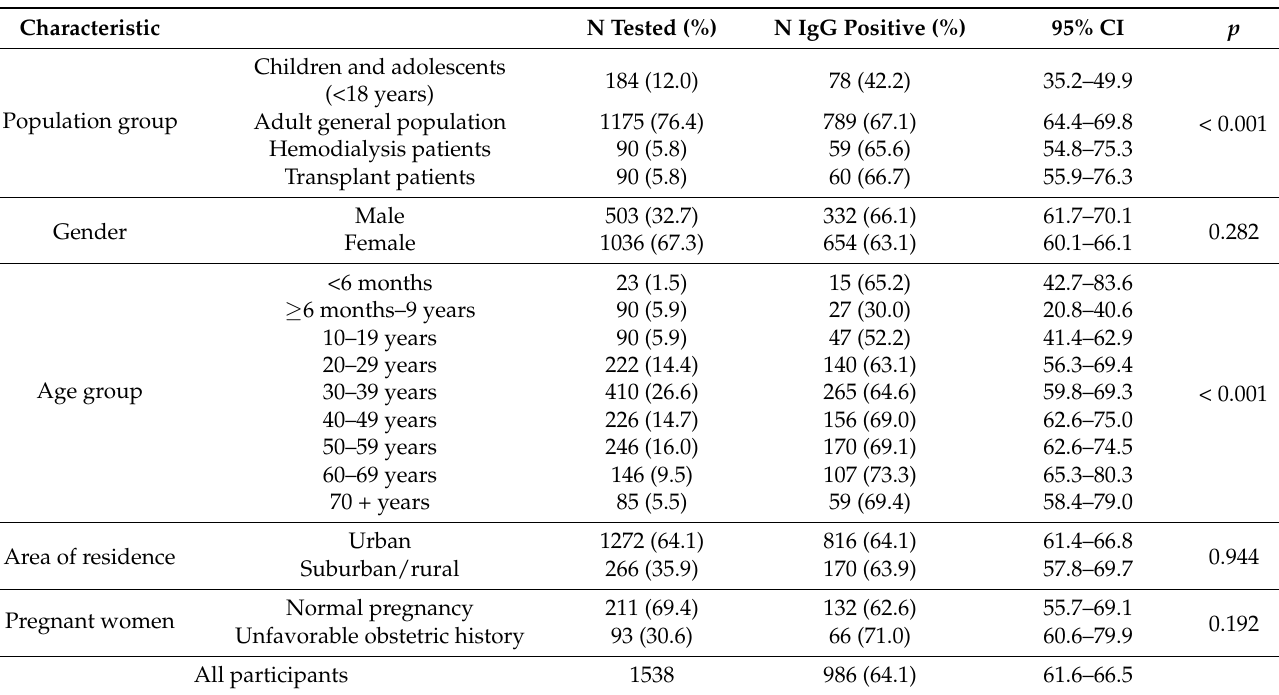
Table 1. Prevalence of parvovirus B19 IgG antibodies.